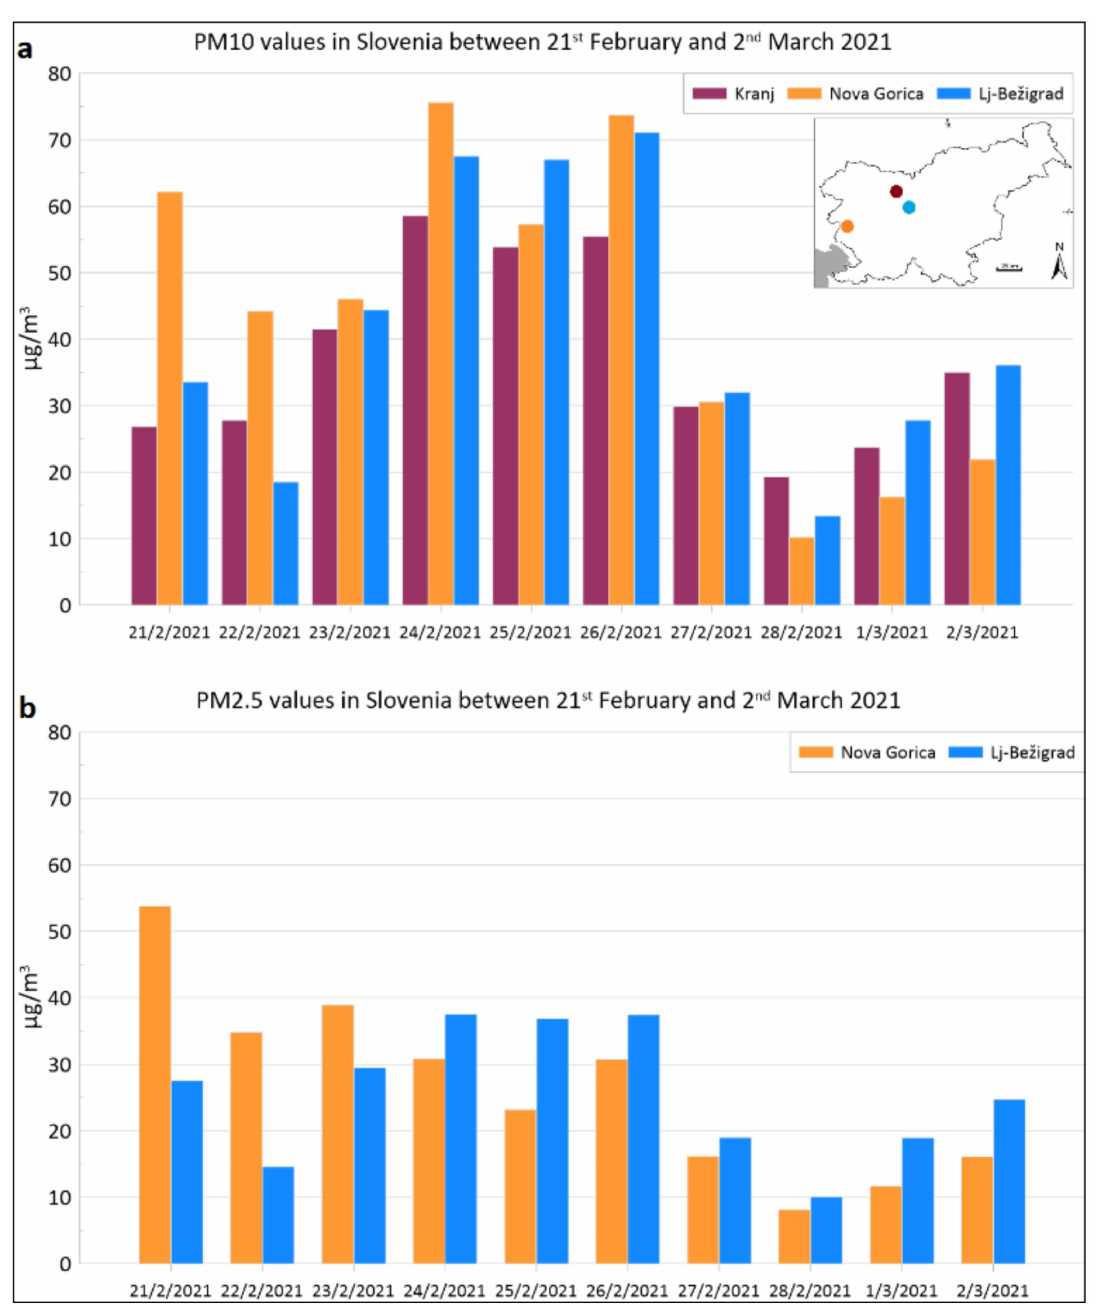
Figure 3. Daily PM10 ( a ) and PM2.5 values ( b ) in Slovenia measured in 3 stations (Ljubljana, Nova Gorica and Kranj) between 21st of February and 2nd of March 2021, showing the influence of the 2021 dust event. Data was provided by Slovenian Environment Agency